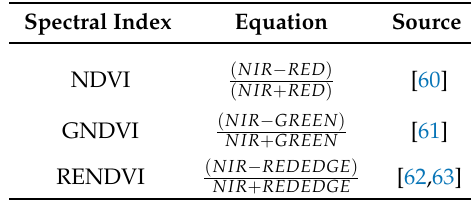
Table 2. Spectral indices calculated from the multispectral imagery. This table is modified from